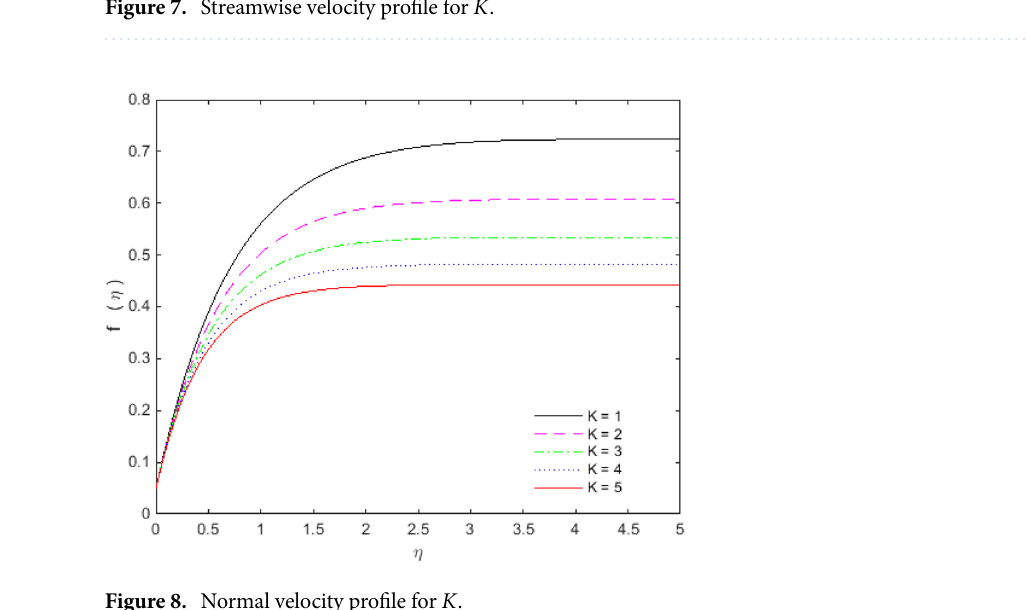
Figure 8. Normal velocity profile for K .